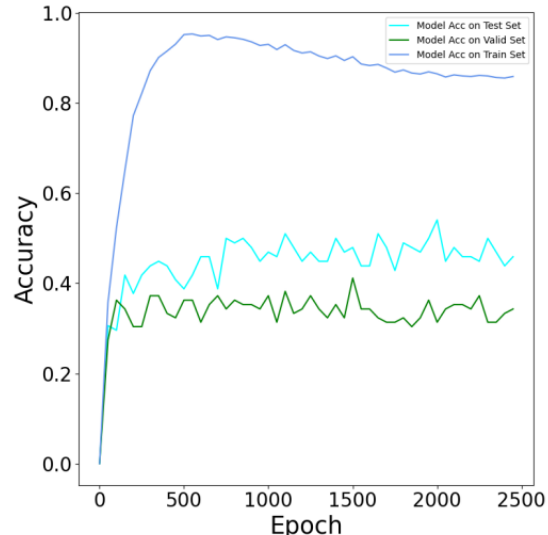
Figure 13. Accuracy of test set verification results of models with different f training times.